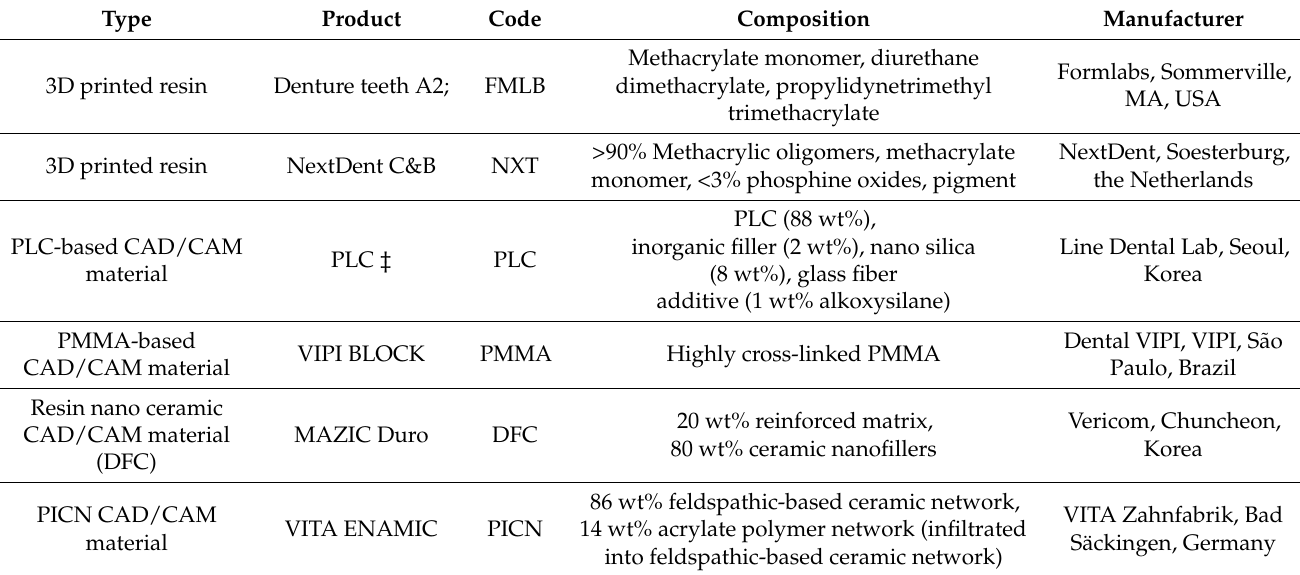
Table 1. Characteristics of 3D printing and CAD/CAM blocks used in this study (The composition was written followed by the manufacturer’s